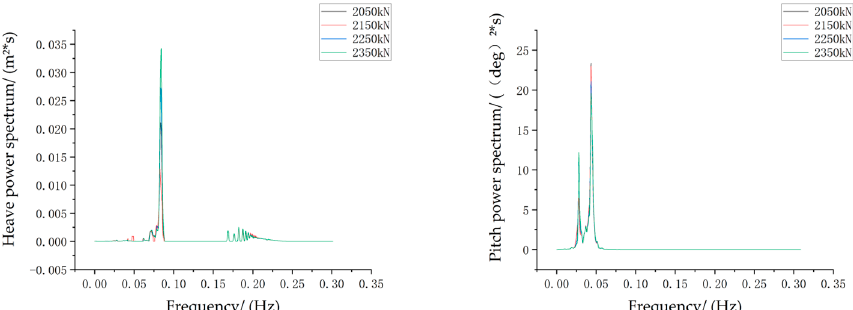
Figure 8. Frequency domain comparison under different rope pretension in normal operating conditions.